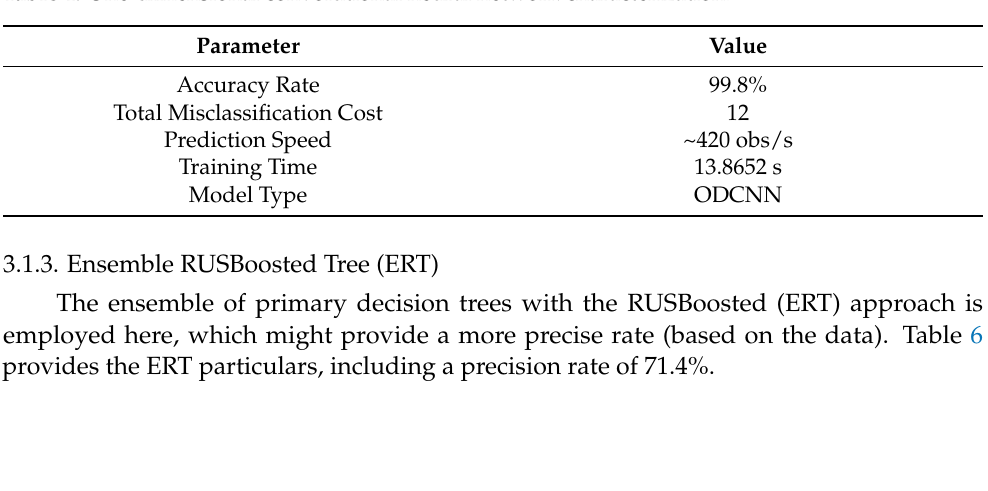
Figure 9. Comparative analysis of identified parameters during different emotional states. Table 4. One-dimensional convolutional neural network